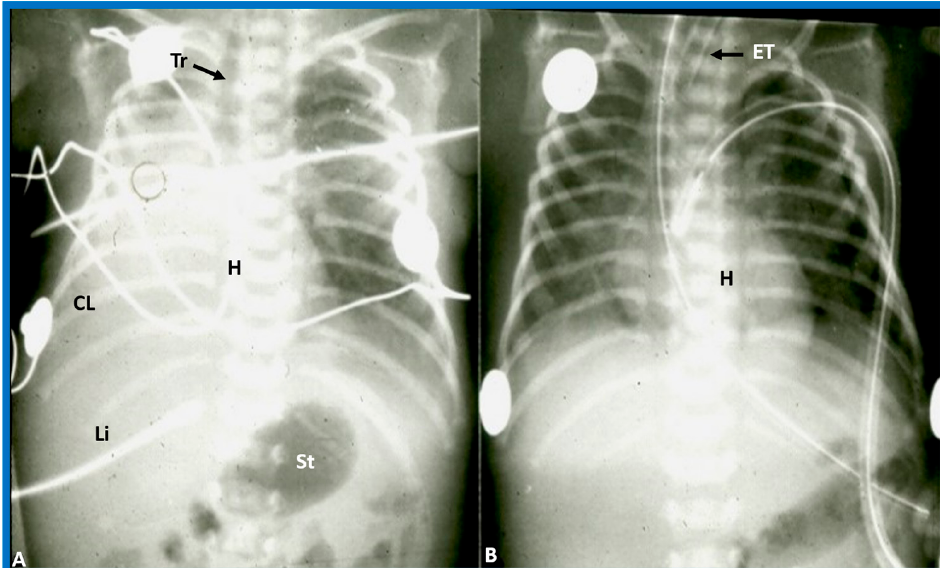
Figure 15. ( A ) Chest x-ray of a baby who had collapsed right lung (CL), pulling the heart (H) to the right, causing dextroposition of the H. The trachea (Tr) is shifted to the right side. The liver (Li) and stomach (St) bubble are in the normal position (situs solitus). ( B ) Following endotracheal (ET) intubation and suctioning, the right lung expanded, returning the H to its normal position. Modified from reference [4].